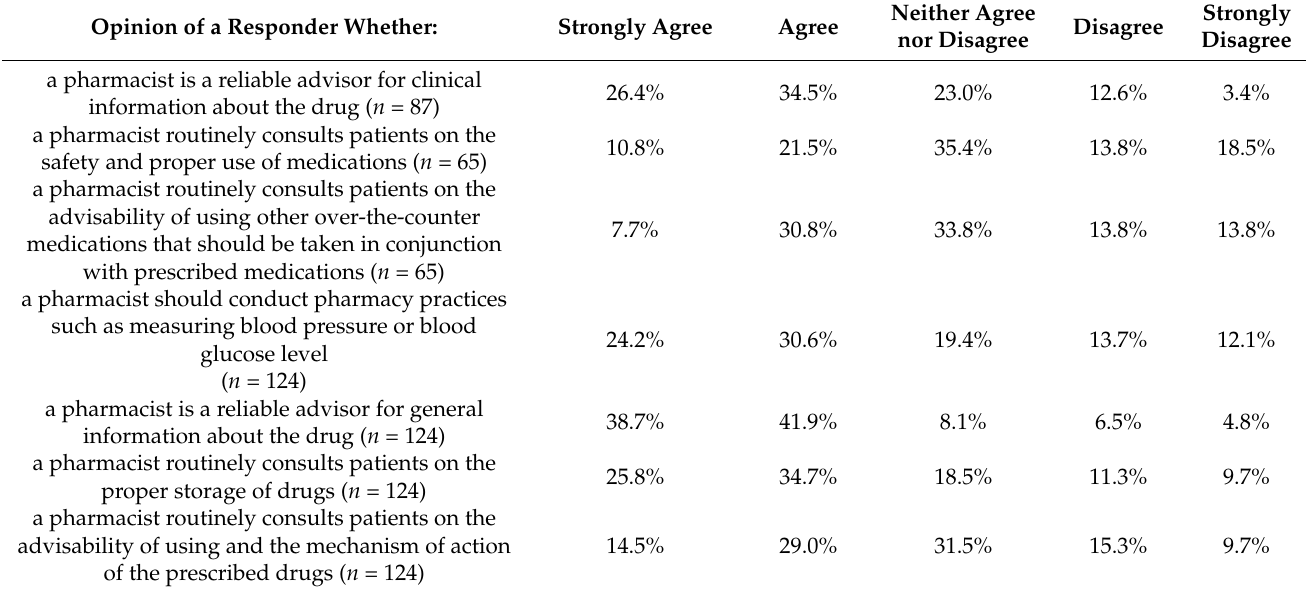
Figure 1. Assessment of the nurses’ opinion of whether the pharmacist is a reliable advisor in the field of general information about the drug, depending on the place of employment ( n = 124, p = 0.044 *, Dunn’s pairwise comparison) Note: * Results statistically significant at α = 0.05. Table 1. Nurses’ previous experience in the field of cooperation with a pharmacist in general.